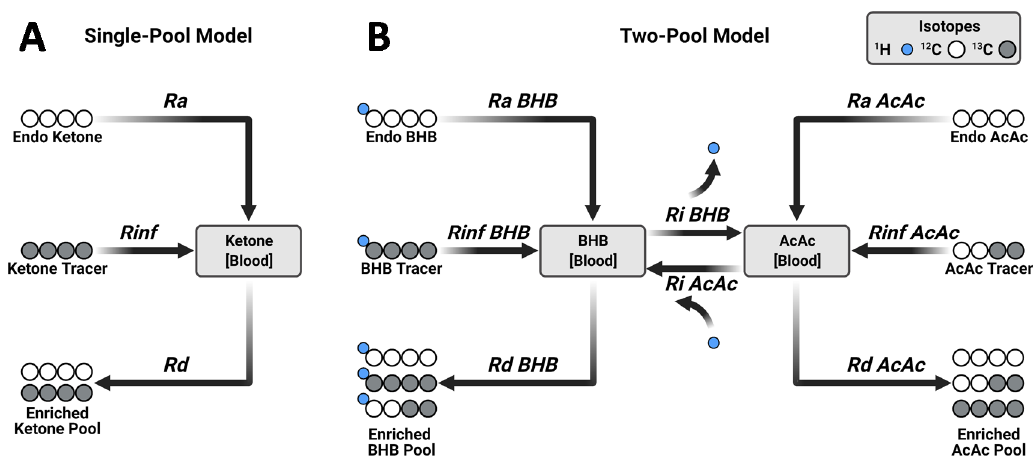
Figure 1. Probing ketogenesis using stable isotope tracers and metabolic flux analysis. ( A ) Single-tracer dilution method for ketone turnover. ( B ) Double-tracer method. Unlike a single-tracer, the double-tracer approach accounts for exchange between BHB and AcAc pools. Ra —rate of appearance, Rinf —rate of tracer infusion, Rd —rate of disposal, Ri —rate of interconversion. Panel ( A ) represents the utilization of a uniformly labeled ketone tracer (i.e., [U- 13 C 4 ]), while panel ( B ) corresponds to the simultaneous utilization of [U- 13 C 4 ]BHB and [3,4- 13 C 2 ]AcAc as tracers.